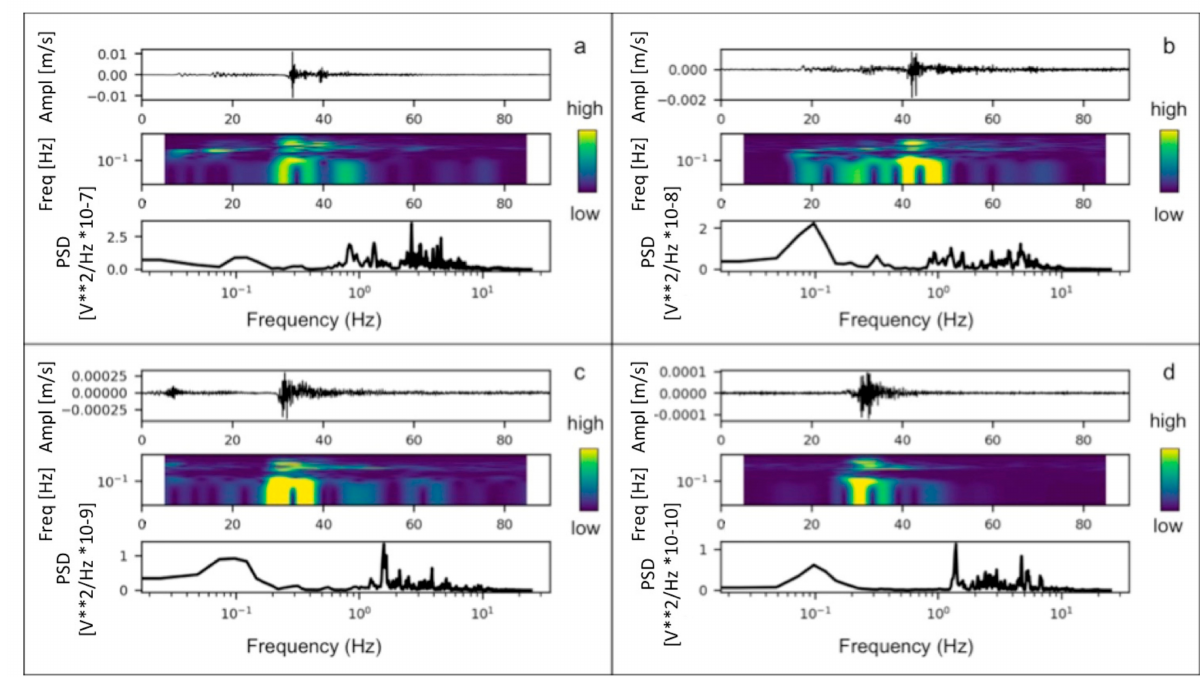
Figure 15. Seismograms (top), spectrograms (middle) and spectra (bottom) of four examples of explosions of different sizes. ( a ) The paroxysmal explosion of 19 July 2020 (03:00 UTC); ( b ) the major explosion on 10 November 2020 (20:04 UTC); ( c ) the explosion on 21 November 2020 (00:33 UTC); ( d ) an ordinary explosion on 19 July 2020 (02:54 UTC). In the horizontal axes of seismograms and spectrograms, time is expressed in seconds.